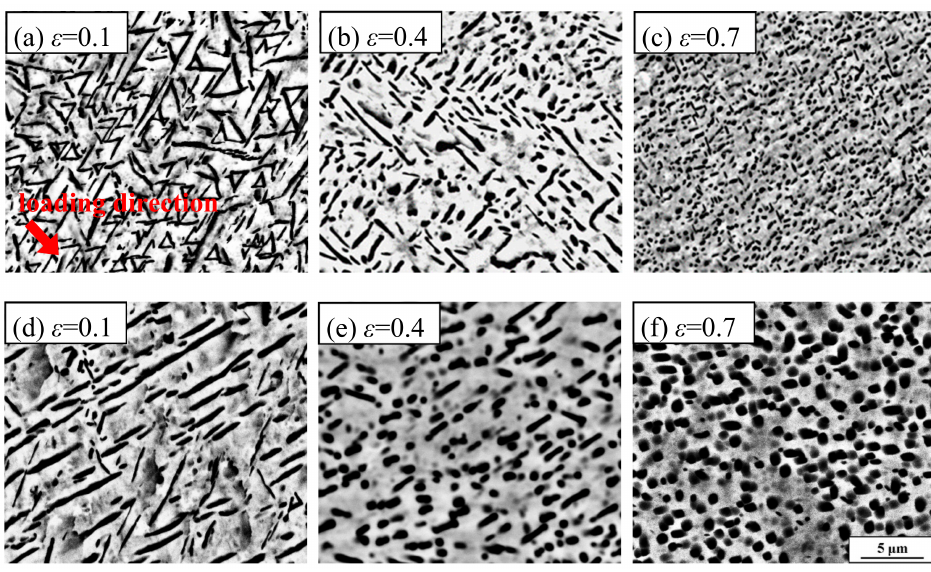
Figure 10. Micrograph of Ti-55531 after compressing at 750 ◦ C/10 − 1 s − 1 ( a – c ) and 775 ◦ C/10 − 3 s − 1 ( d – f ) to the strain of 0.1, 0.4, and 0.7,